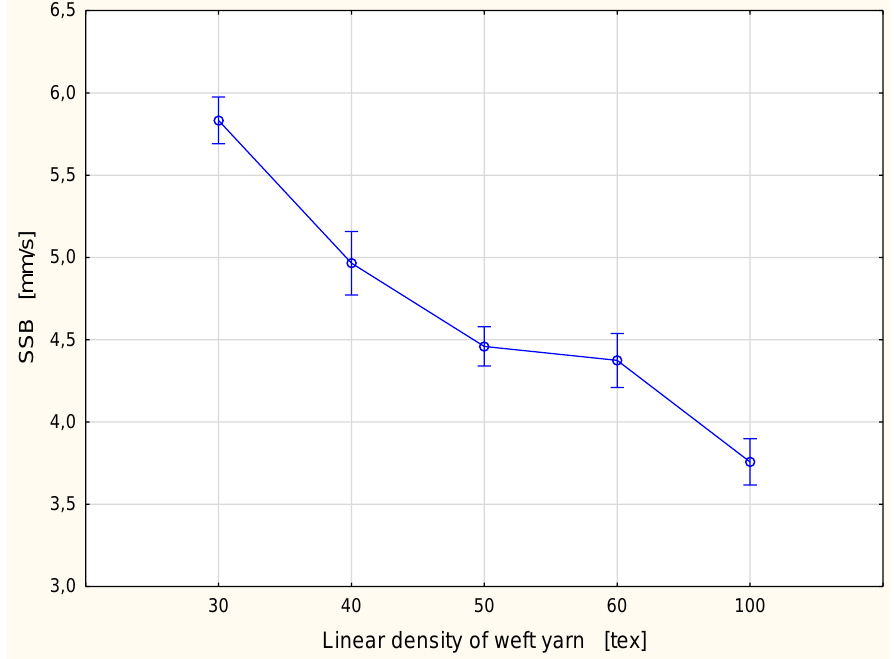
The influence of the linear density of the weft yarn on the absorption rate in the wo- Figure 7. Spreading speed for the bottom fabric surface vs. linear density of the weft yarn. Figure 7. Spreading speed for the bottom fabric surface vs. linear density of the weft yarn. ven fabrics needs further investigation.